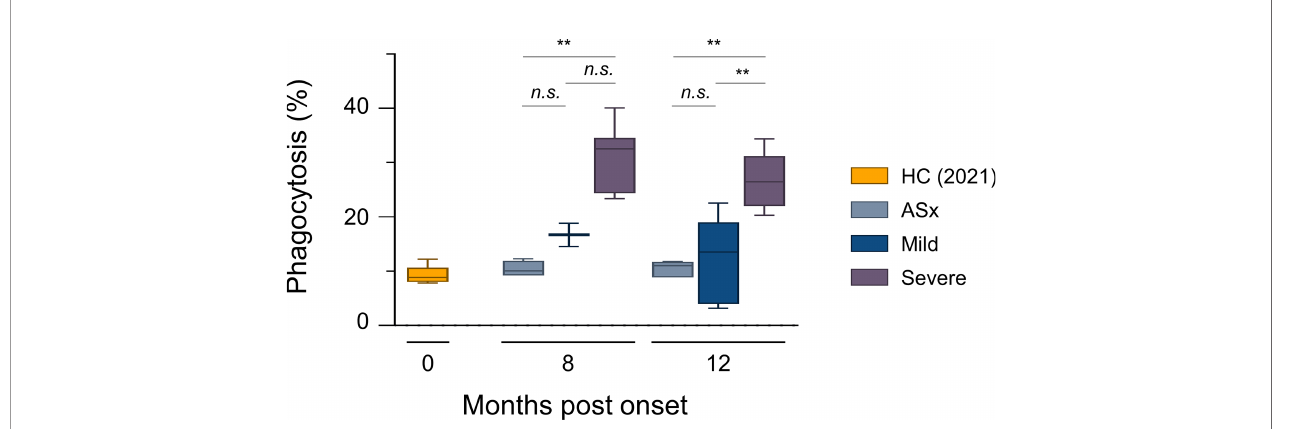
FIGURE 2 | In vitro phagocytic capability assays according to the severity of illness. ADCP assays with THP-1 cells as effectors and RBD-coated fl uorescent, carboxylate-modi fi ed 1 m m red (580/605 nm, F8821) bead as targets (effector: target ratio of 10:1). RBD-coated red beads were pre-incubated with the diluted plasma for 20 min and then incubated with THP-1 cells for 2 h. Phagocytic activities were determined by fl ow cytometric analysis. % of Phagocytosis = numbers of red (580/605 nm) − positive THP-1 cells/numbers of total THP-1 cells × 100. Results are representative data from three independent experiments. Statistical analysis was performed using the Kruskal – Wallis rank-sum test with Dunn ’ s post hoc test in GraphPad Prism ( n.s .: P > 0.05, ** P <